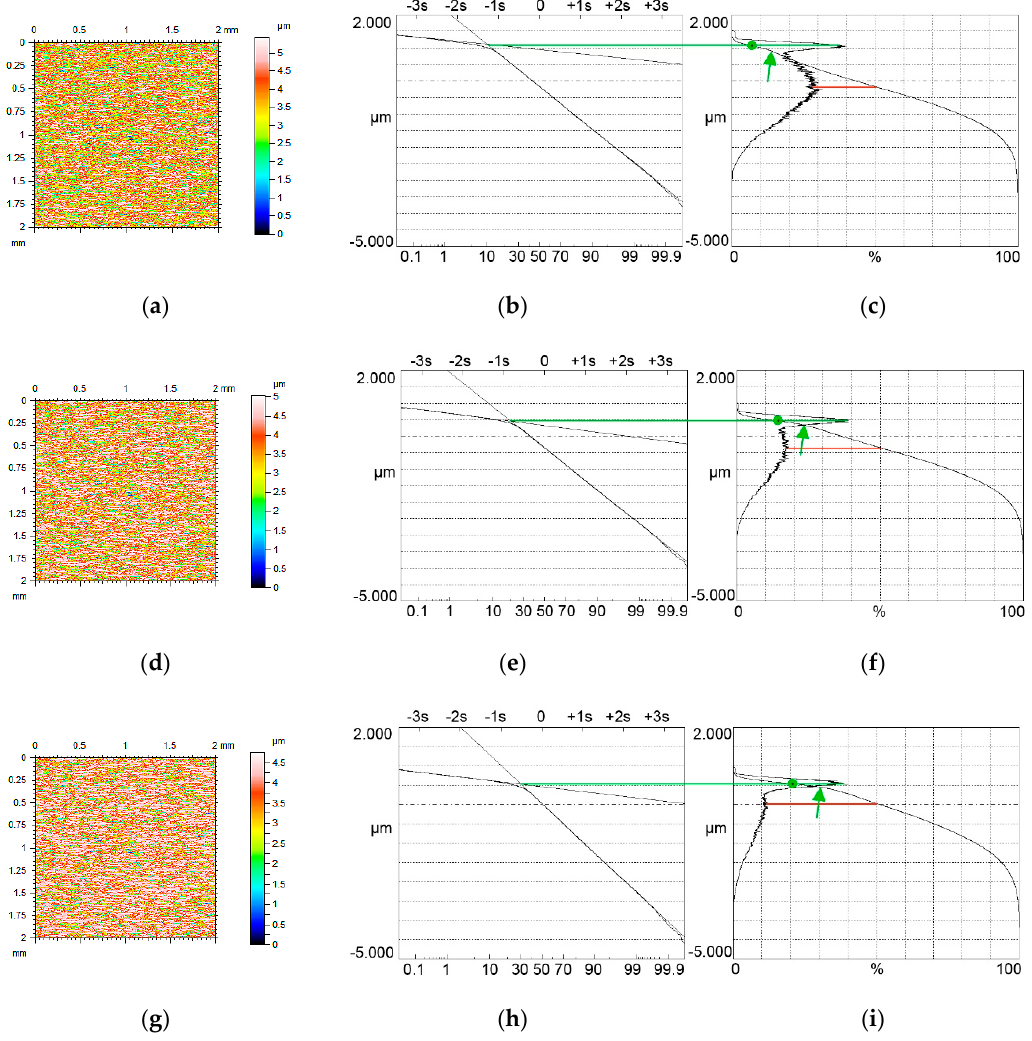
Figure 6. Contour plots ( a , d , g ) surface probability plot ( b , e , h ), material ratio curve and probability distribution ( c , f , i ) of two-process isotropic modeled surfaces of the Smq parameter of 10% ( a – c ), 20% ( d – f ) and 30% ( g – i ), the other parameters of both surfaces are Spq = 0.12 µm, Svq = 1.0 µm, all surfaces have bimodal ordinate distributions.